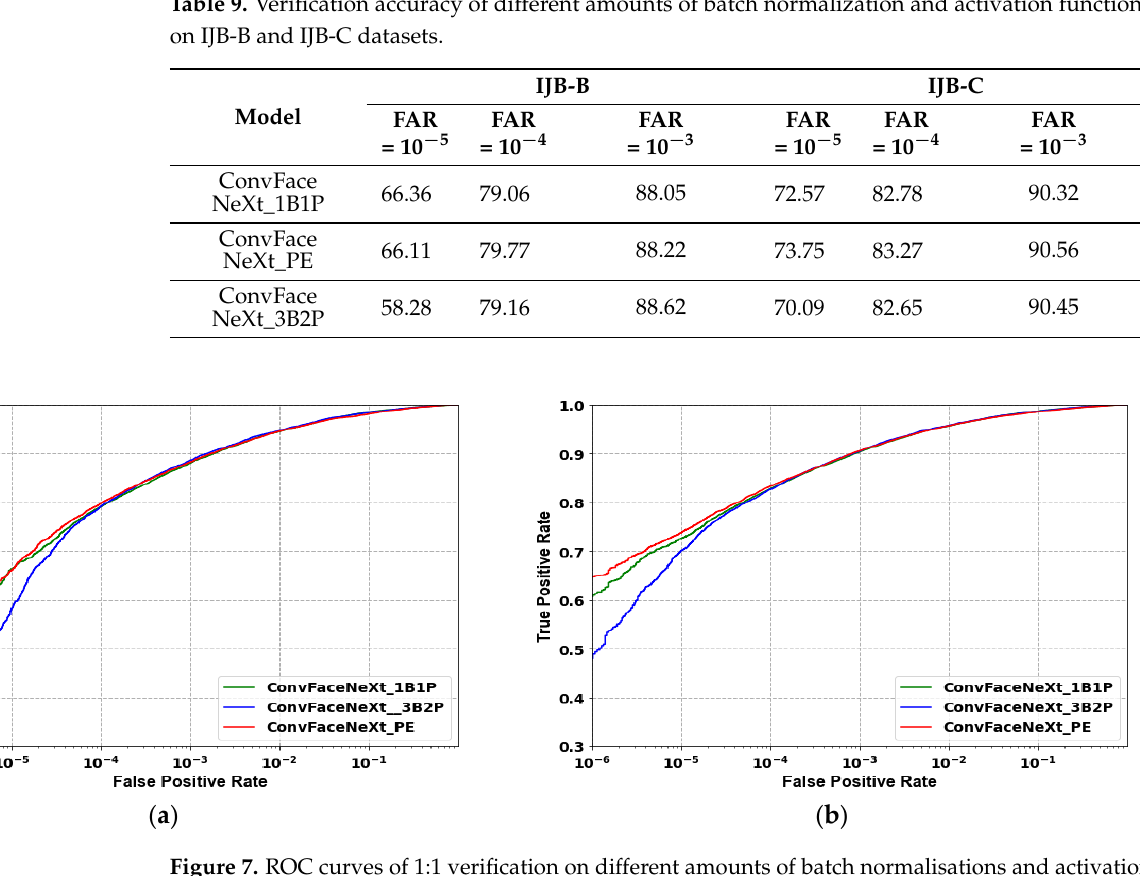
Figure 7. ROC curves of 1:1 verification on different amounts of batch normalisations and activation functions. ( a ) IJB-B dataset. ( b ) IJB-C